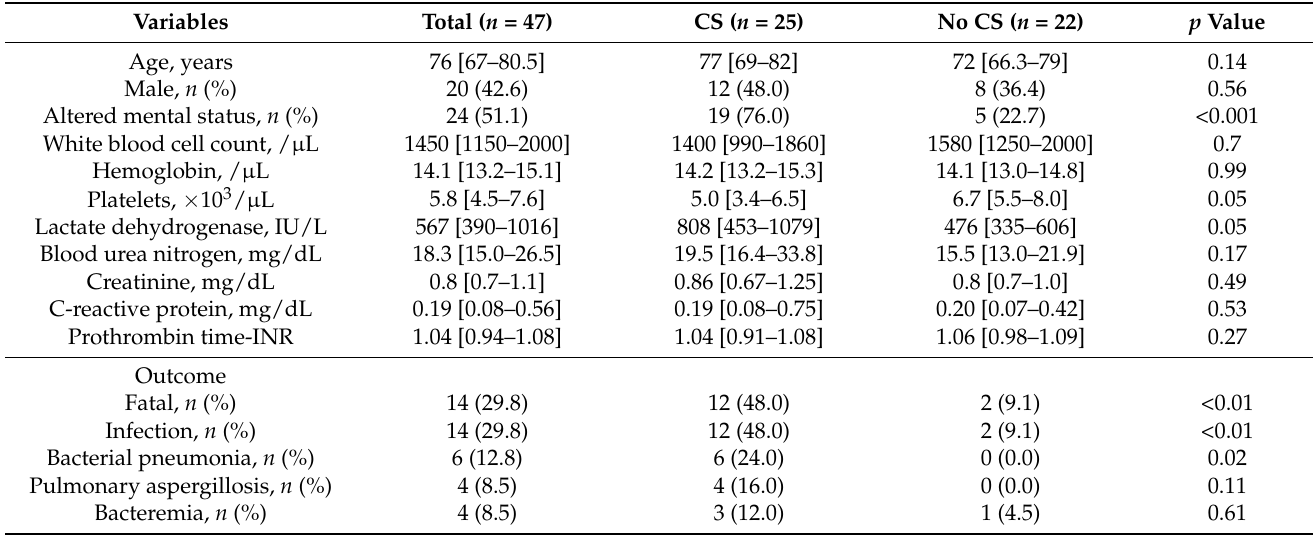
Table 3. Clinical characteristics of the subjects according to CS use.